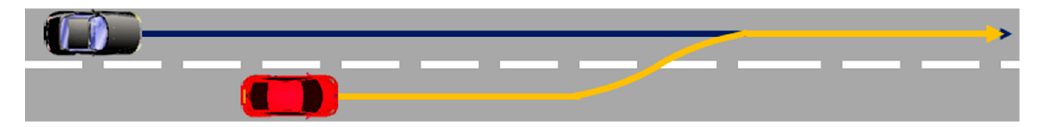
Figure 3. Initial state in lane change scenario for training.